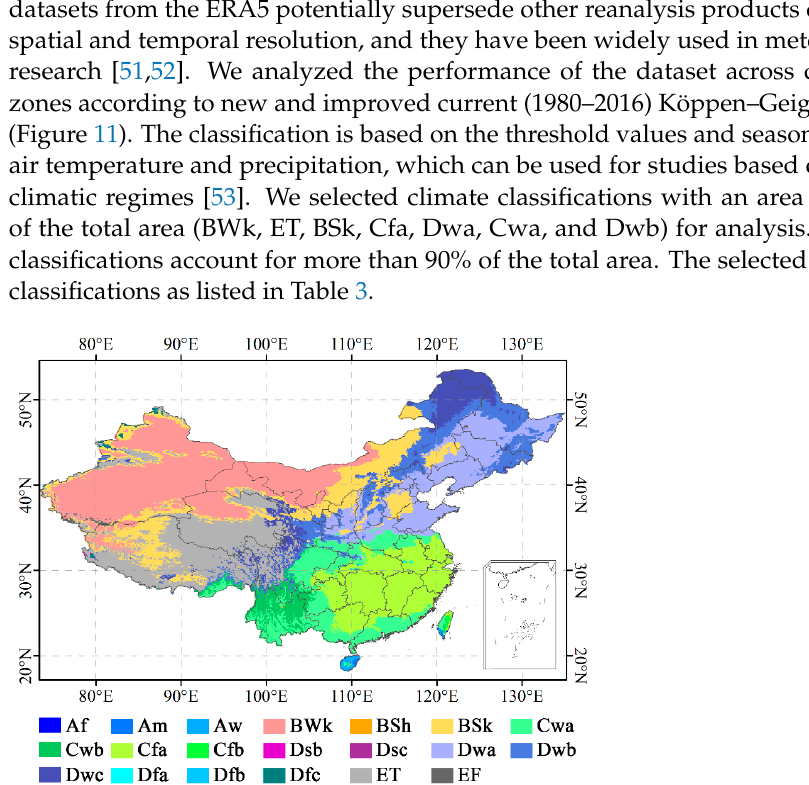
Figure 11. New and improved current (1980–2016) Köppen-Geiger classifications of China (for ex- planations of the abbreviations, please see Table 3). Table 3. Köppen–Geiger classifications and their area proportions of China (classifications with area proportions greater than 8% were selected for further